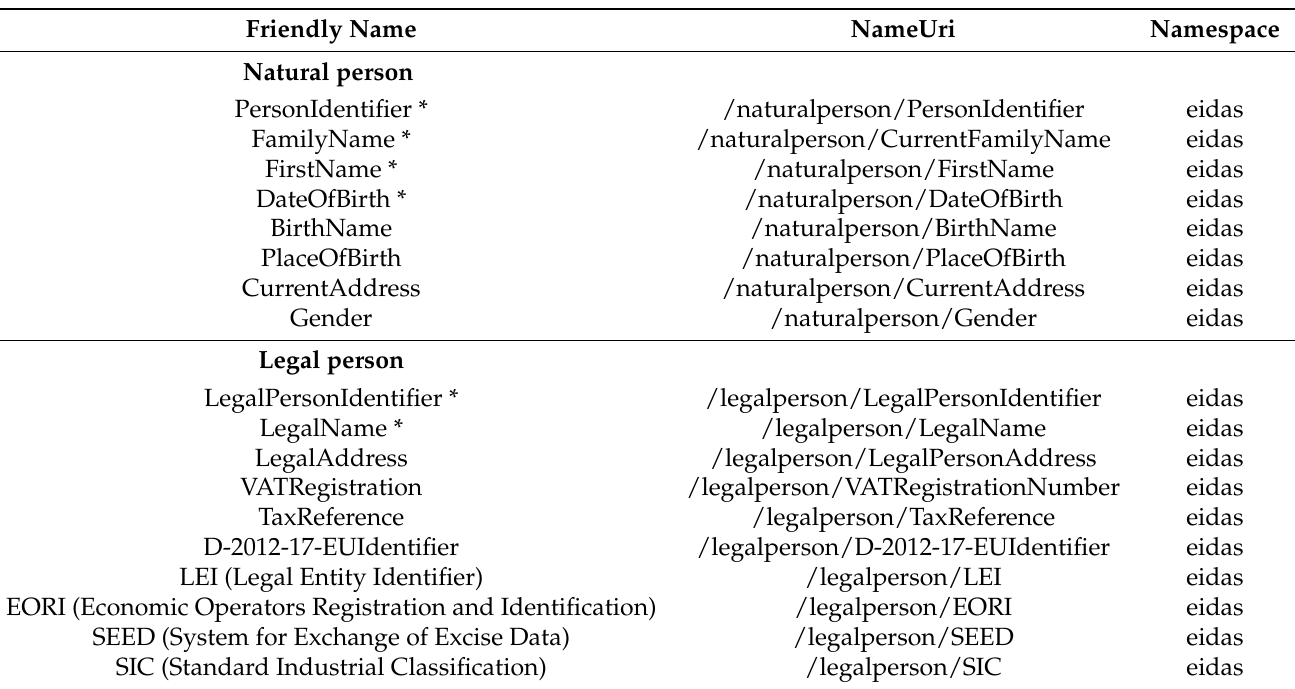
Table 1. Available natural and legal person attributes in eIDAS